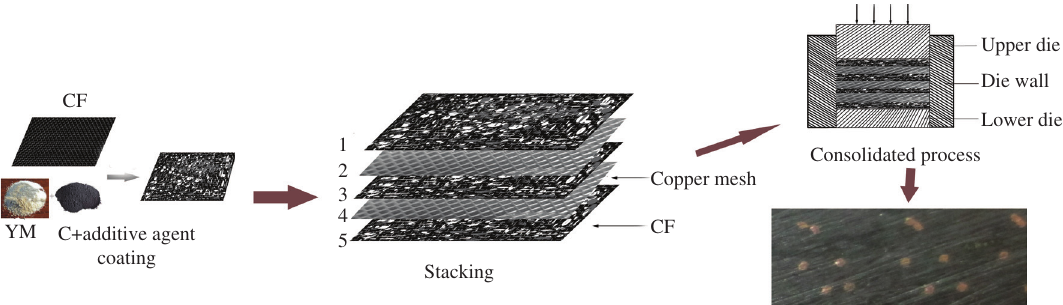
Figure 1 Scheme of preparation process of